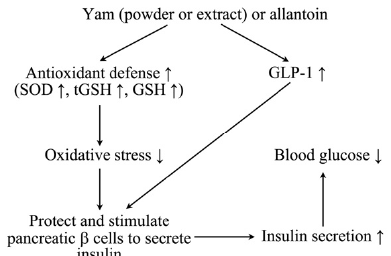
Figure 9. Schematic diagram of the proposed mechanisms by which powder or water extract of yam ( Dioscorea batatas ), and allantoin regulate blood glucose. Administration of yam or allantoin increased the GLP-1 level, responsible for enhancing insulin biosynthesis and transcription, improved β -cell function and mass, and reduced apoptosis in β -cells, controlling insulin and glucose levels. They also increased the antioxidant level and decreased the MDA level, which ultimately decreased oxidative stress protecting pancreatic β -cells and other organs.